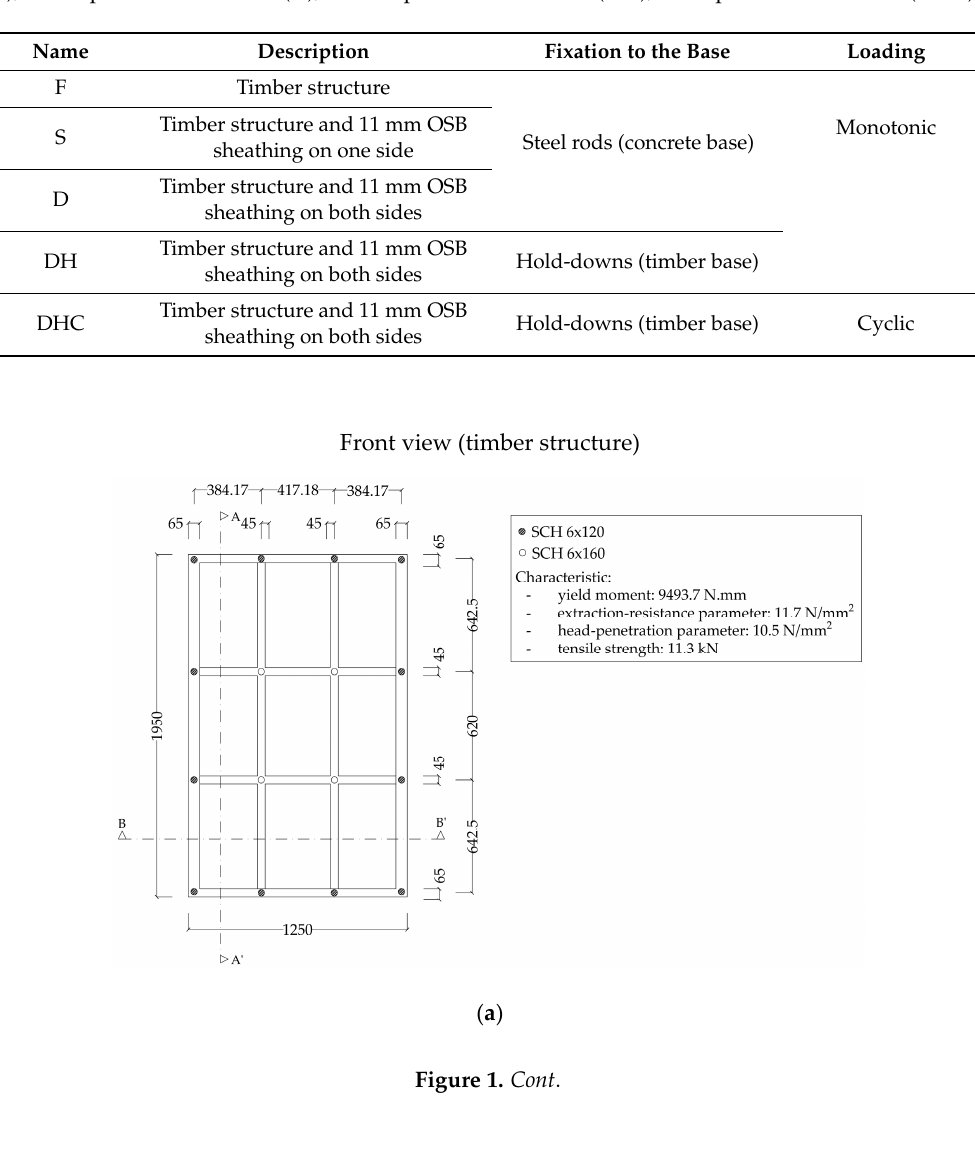
Table 1. Description of the specimens tested. First specimen evaluated (F); second specimen considered (S); third specimen evaluated (D); fourth specimen evaluated (DH); fifth specimen evaluated (DHC).